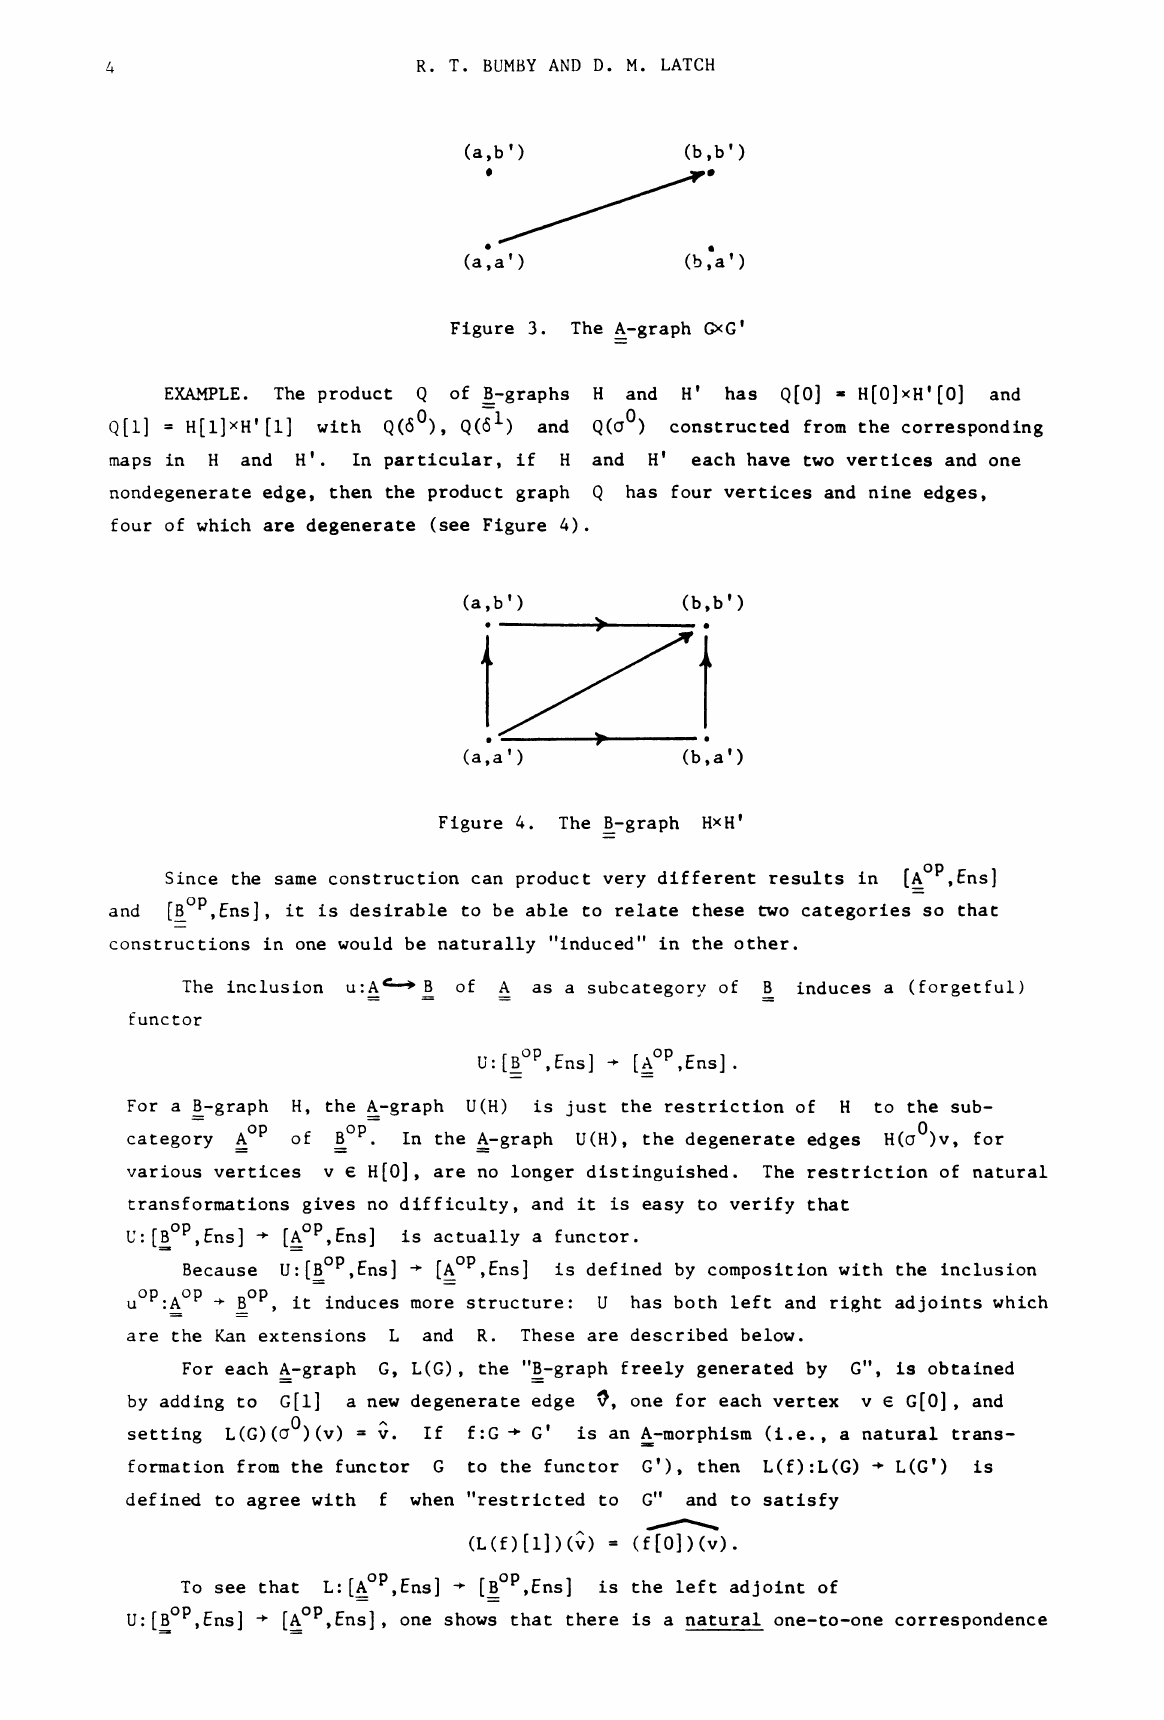
Figure 3. The A-graph GxG’